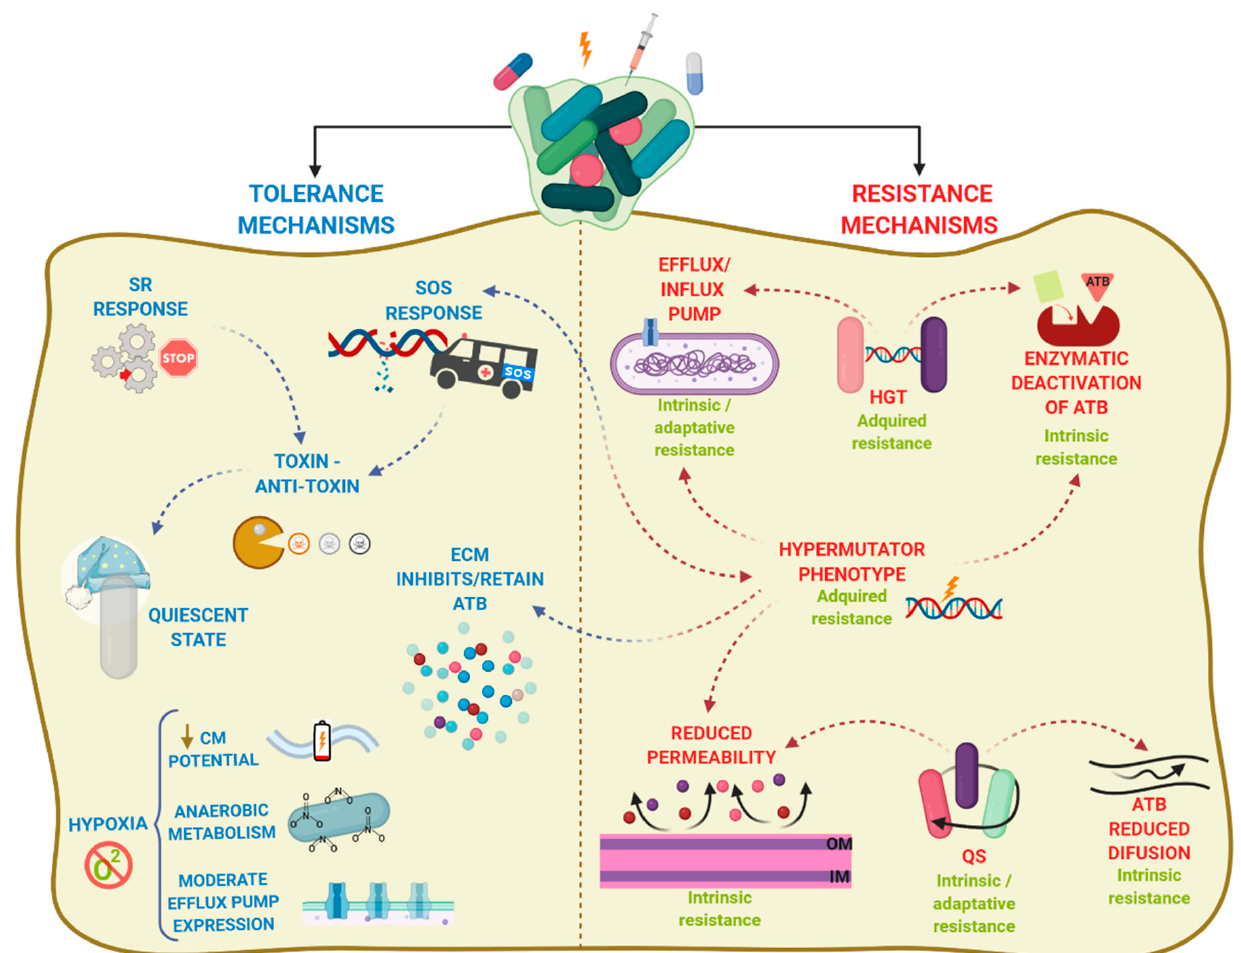
Figure 2. Mechanisms of biofilms recalcitrance. Biofilm recalcitrance comprises a combination of antibiotic (ATB) resistance mechanisms (right panel) and ATB tolerance mechanisms (left panel). Resistance mechanisms confer the ability to survive and grow at increased ATB concentrations for long periods and involve horizontal genetic transfer (HGT), hypermutation, and quorum sensing (QS), leading to transport of antibiotics via efflux pumps, reduced permeability of the outer membrane, or production of enzymes that inactivate ATB. The type of AMR (Box 1) is indicated in green. In contrast, tolerance mechanisms lead microorganisms to survive at increased ATB concentrations temporally, and involve activation of stress responses (SOS response, stringent response SR)) and hypoxia, leading to activation of a quiescent state, anaerobic metabolism, decrease of membrane potential, and moderate increase in efflux pump expression. Arrowhead lines indicate the interrelation between mechanisms. CM: cytoplasmic membrane.